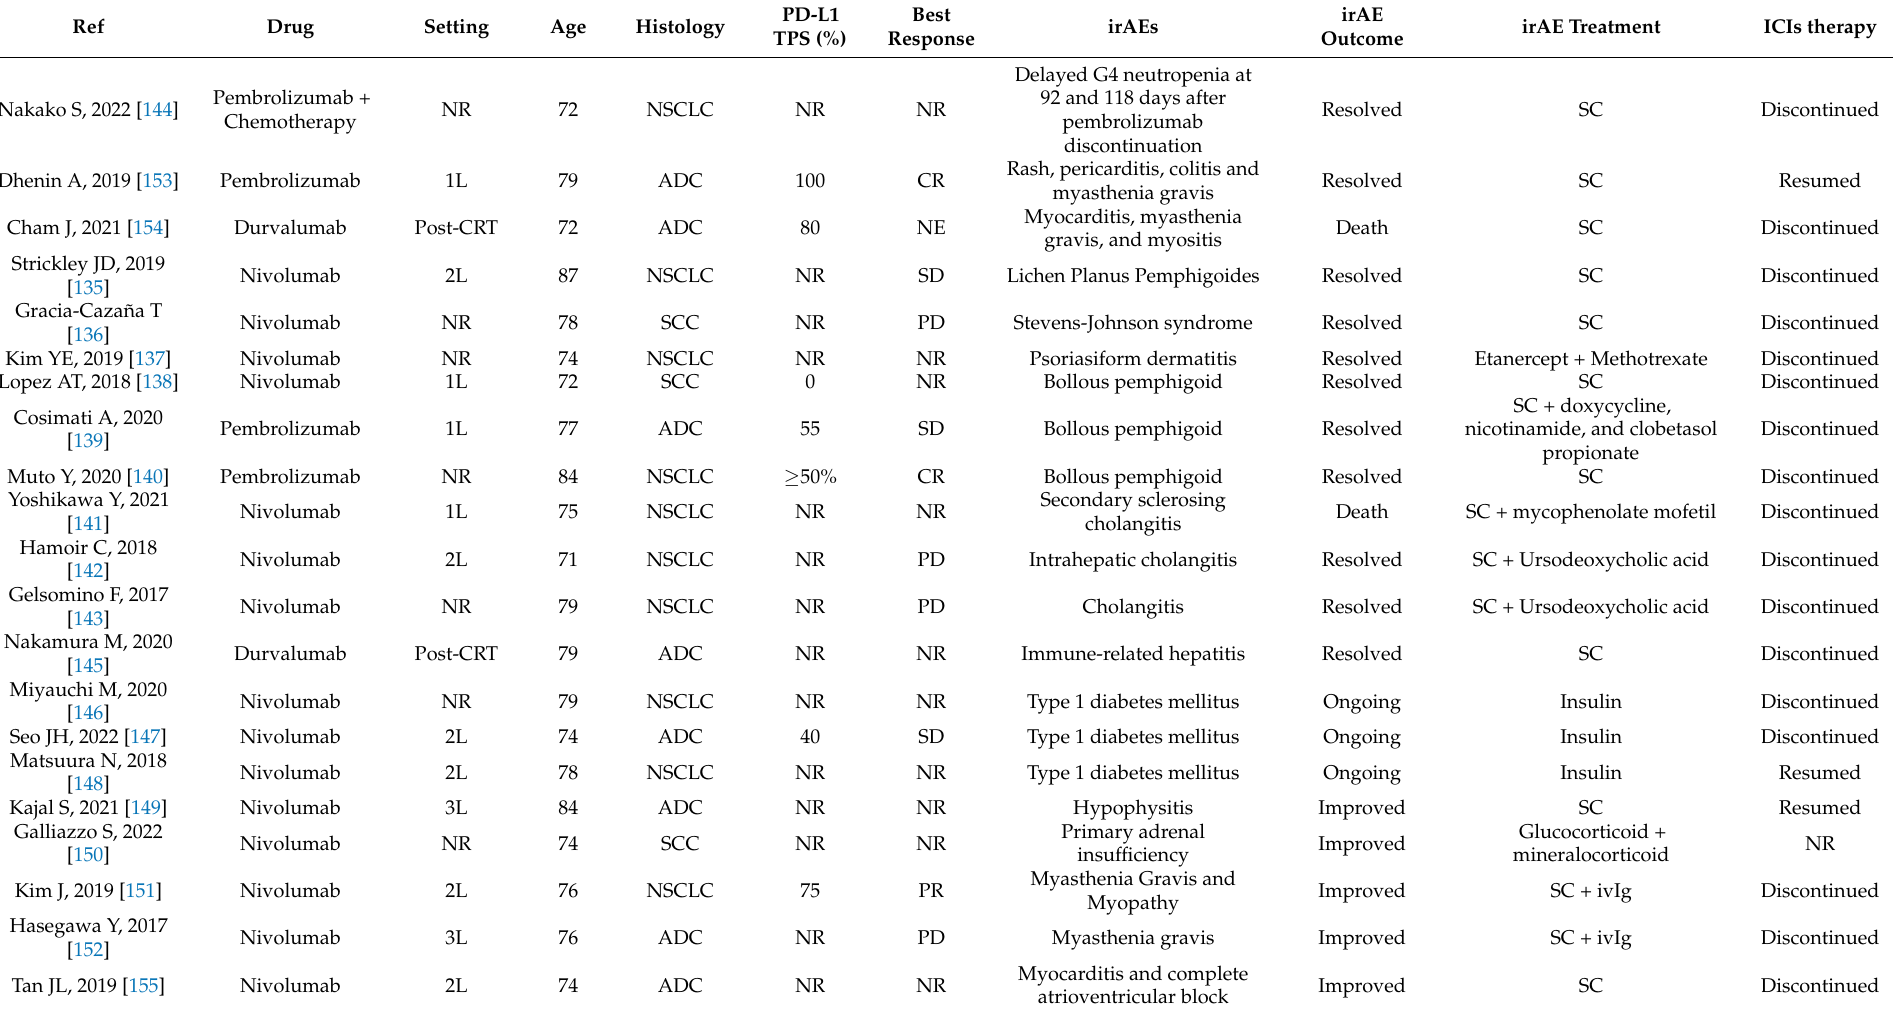
Table 2. irAEs of special interest in elderly people treated with PD1/PD-L1